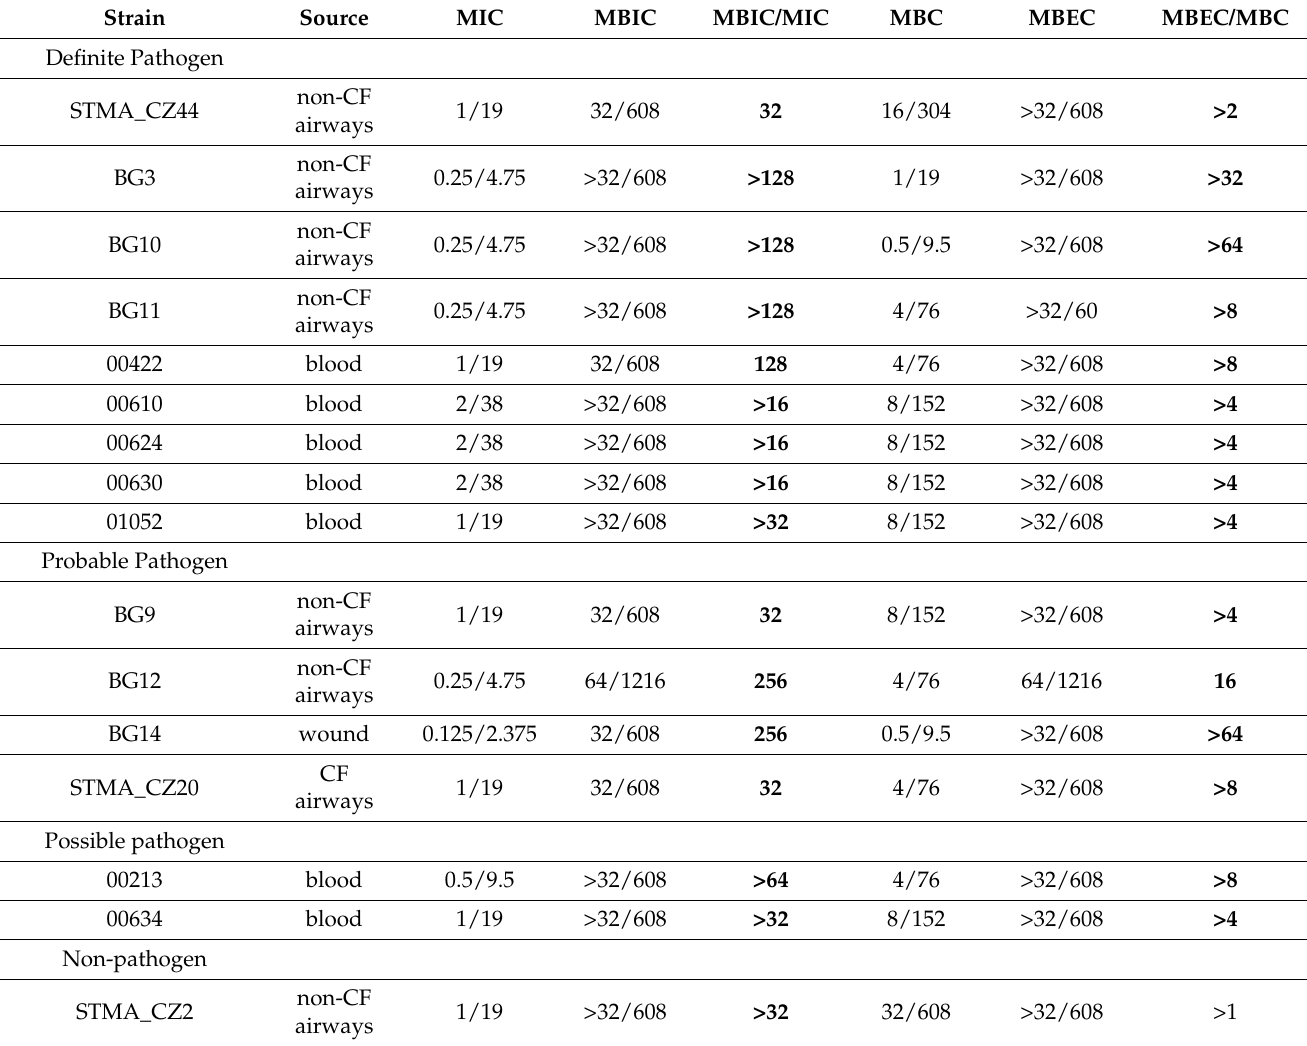
Table 3. In vitro susceptibility of preformed biofilms by S. maltophilia to cotrimoxazole. Minimum Biofilm Inhibitory Concentration (MBIC) and Minimum Biofilm Eradication Concentration (MBEC) values, expressed as µ g/mL, were measured for a set of strains representative of different pathogenetic roles and sources. Statistically significant MBEC/MBC values (significance set at >2) are in bold. According to Stepanovi´c et al. [24], all strains are “strong-producers”, except for BG12